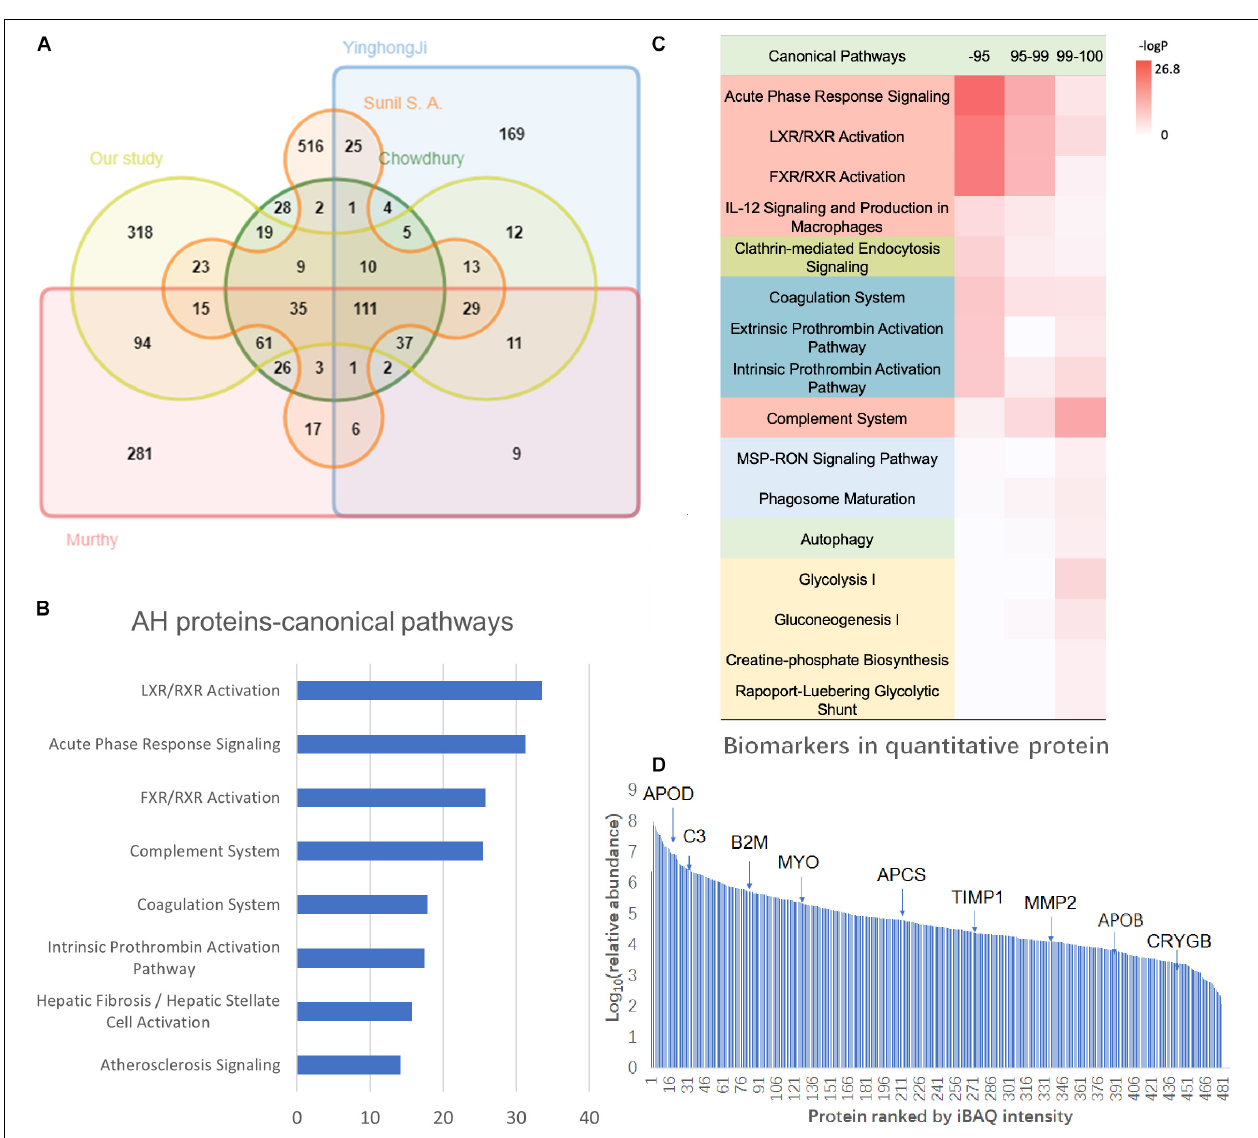
FIGURE 2 | The AH proteome analysis of the present study. (A) The Venn diagram of the identified proteins and comparison of the present results with the previous AH proteome data. (B) The Ingenuity Pathway Analysis (IPA) canonical pathway analysis of the AH proteome. (C) The hierarchical clustering based on the intensity-based absolute quantification (iBAQ) quantification and IPA annotation. (D) The dynamic range of the AH proteome with key biomarkers marked. The X -axis indicates the protein numbers ranked by the iBAQ intensity, and the Y -axis indicates the log10 (relative intensity) of the